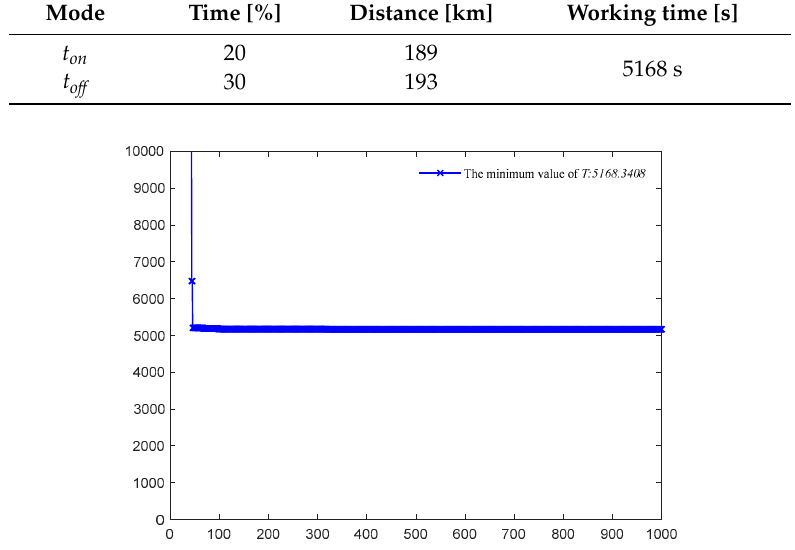
Figure 10. Convergence curve of t optimized with BSAII.